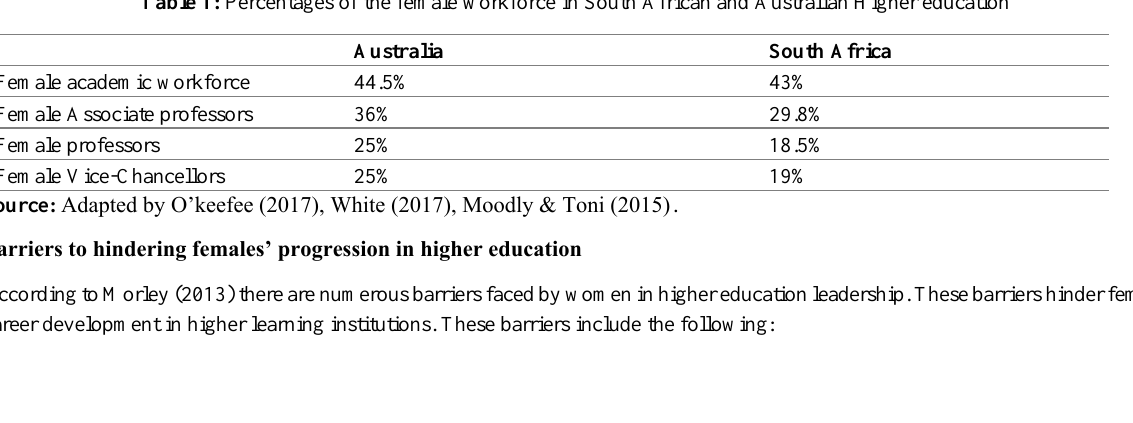
Table 1: Percentages of the female workforce in South African and Australian Higher